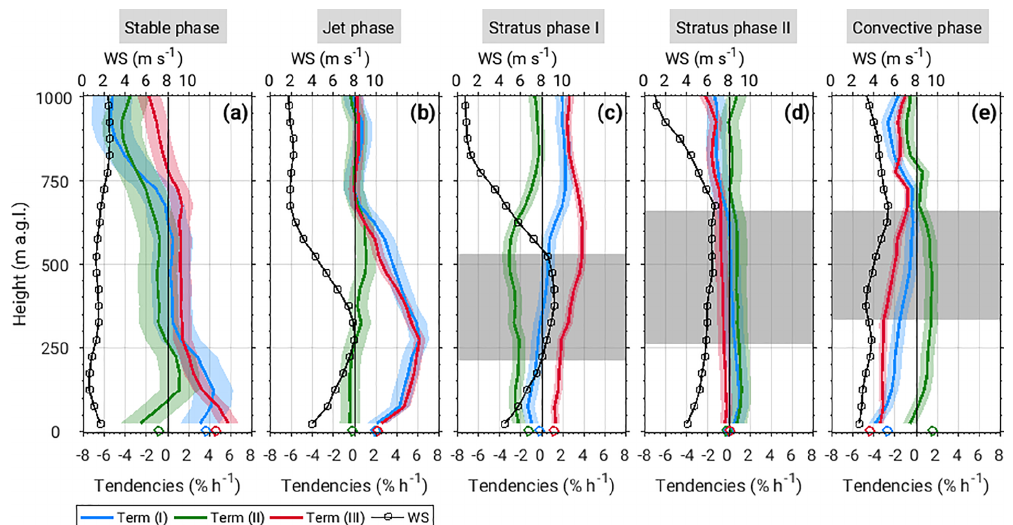
Figure 7. The observed RH tendency profiles (Term (I) in Eq. 1) obtained from radiosonde measurements for different phases during IOP 8 are shown in blue. The contributions from the specific humidity changes (Term (II) in Eq. 1) and temperature changes (Term (III) in Eq. 1) are shown in green and red, respectively. The shading indicates the range of uncertainty of each term determined based on the uncertainty propagation calculations. The colored circles show values of different terms of Eq. (1) obtained from near-surface measurements. The black circles denote the median horizontal wind speed (WS) profile for each phase. The mean cloud layer is indicated in gray